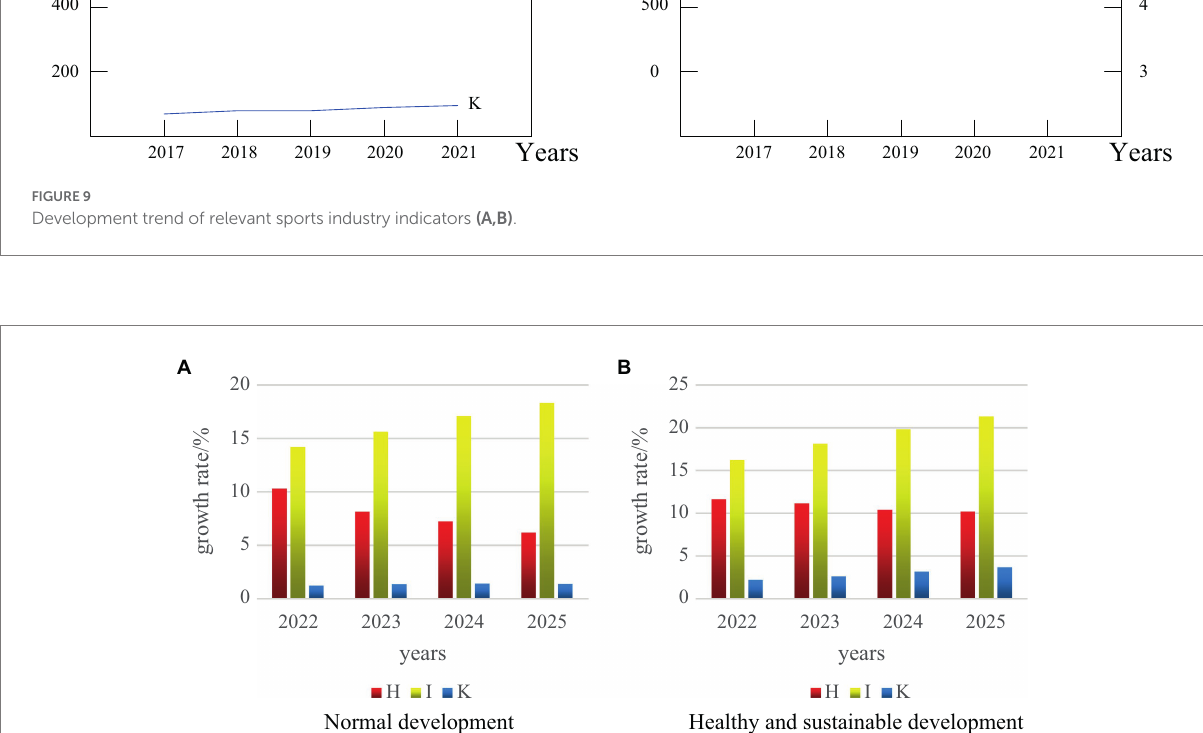
FIGURE 10 Prediction of H, I, and K three indicators. (A) Normal development. (B) Healthy and sustainable